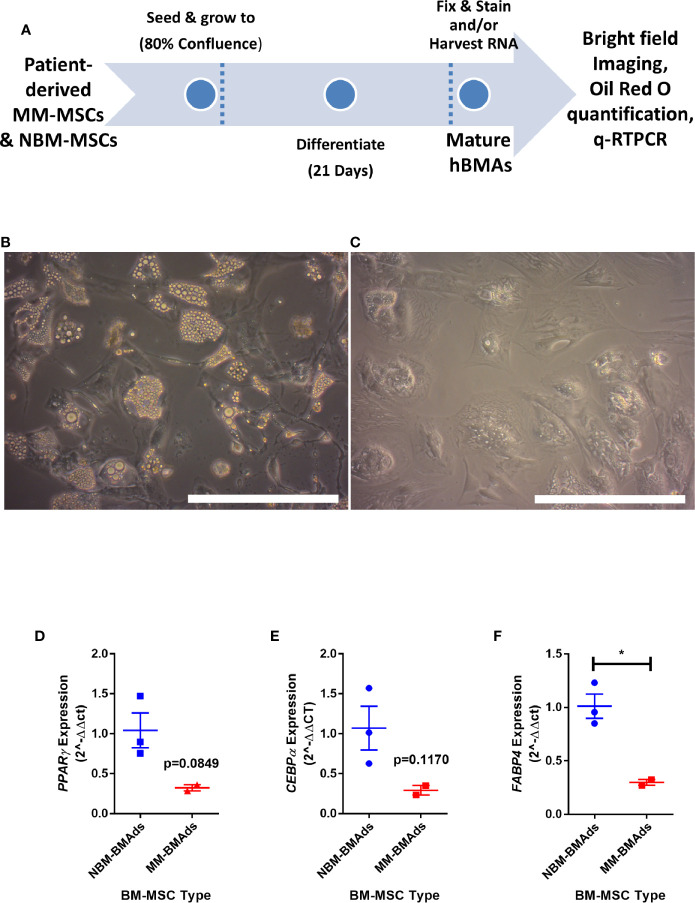
Mesenchymal stromal cells (MSCs) derived from myeloma patients exhibit impaired adipogenic differentiation. Experimental design of MSC differentiation experiment (A). MSCs differentiated into adipocytes for 21 days from normal donor bone marrow (NBM-BMAds), (B), or myeloma patient bone marrow (MM-BMAds, (C) for 21 days; images taken at 20X, scale bars = 250 µm. PPARG
(D), CEBPA
(E), and FABP4
(F) expression are decreased at the end of the adipogenic differentiation period in adipocytes derived from myeloma patient MSCs (MM-BMAds), relative to normal donor controls (NBM-BMAds) (n=3); *p < 0.05.